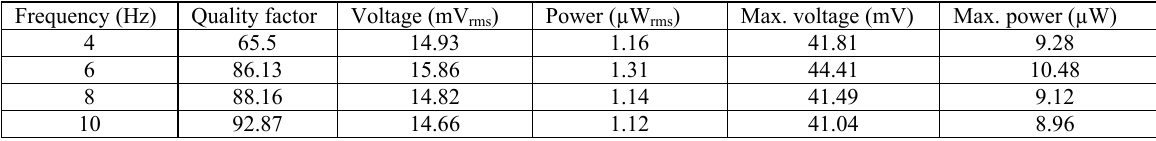
Table 2. Comparison of experimental results in different modes Frequency (Hz) Quality